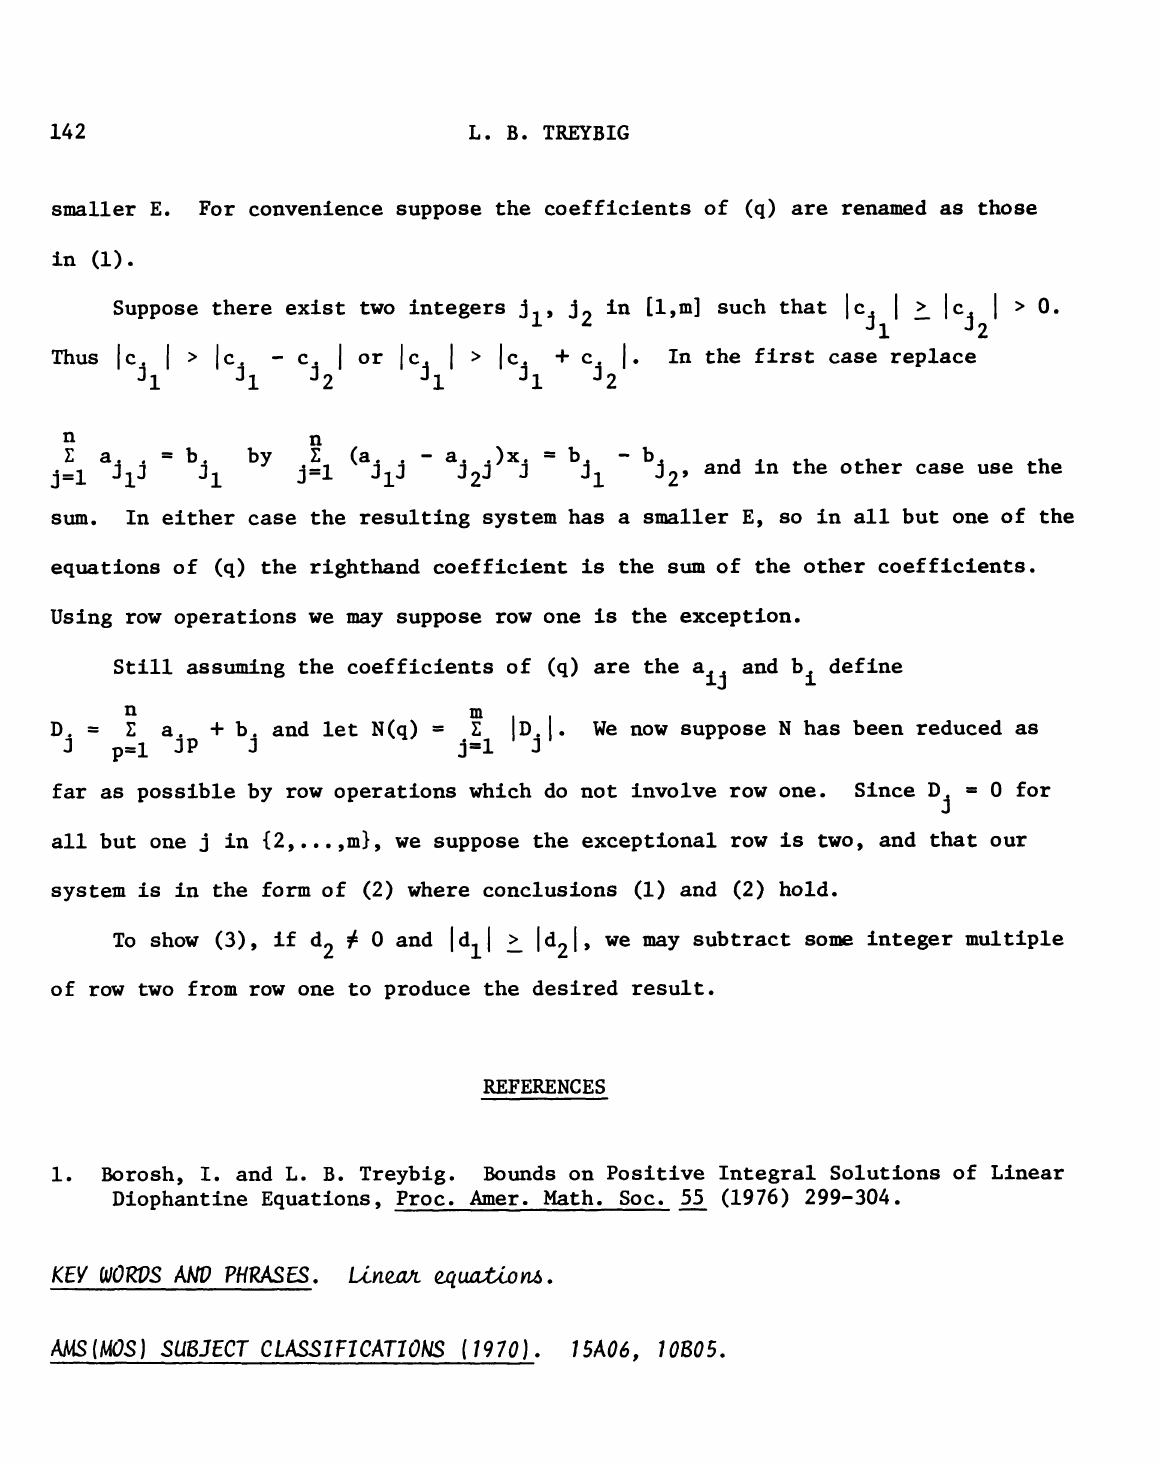
Linear eqns. AMS(MOS) SUBJECT CLASSIFICATIONS